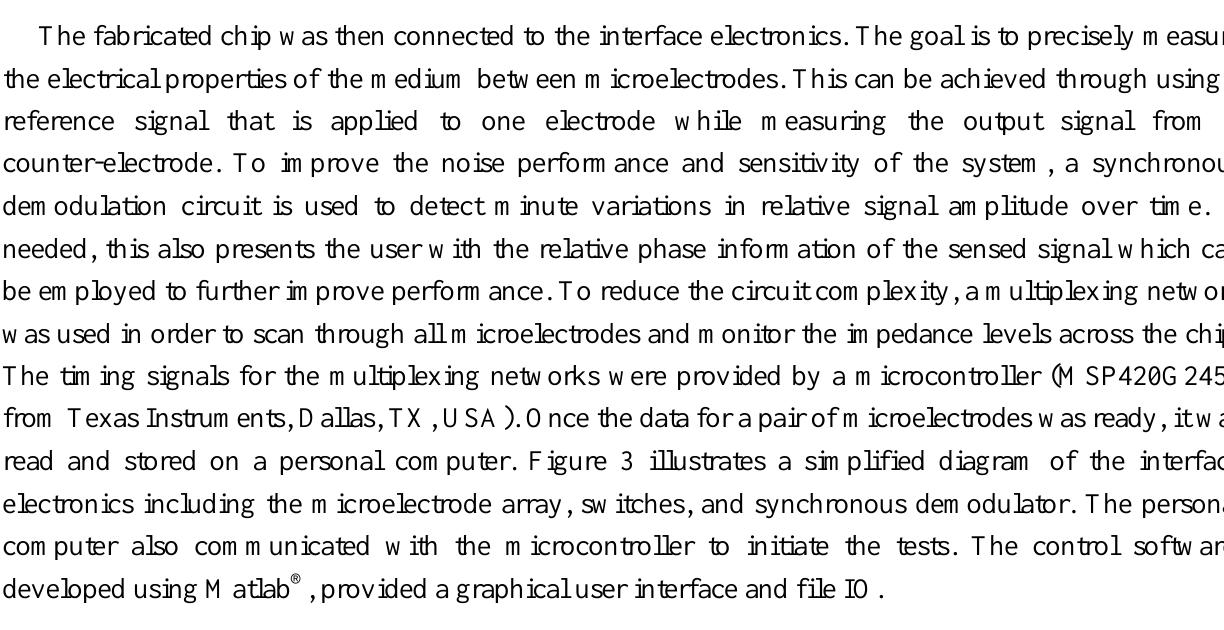
Figure 3. Simplified schematic of the multiplexing and measurement electronics. The timing signals for the switches are shown at the